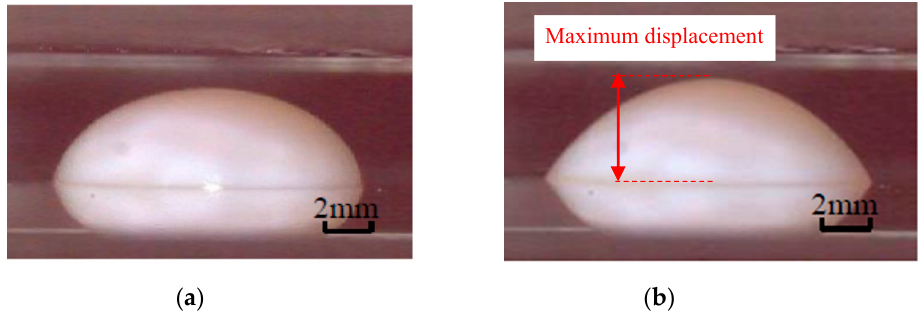
Figure 2. Displacement of the polishing slurry in non-uniform electric field: ( a ) Initial state; ( b ) Maximum displacement.